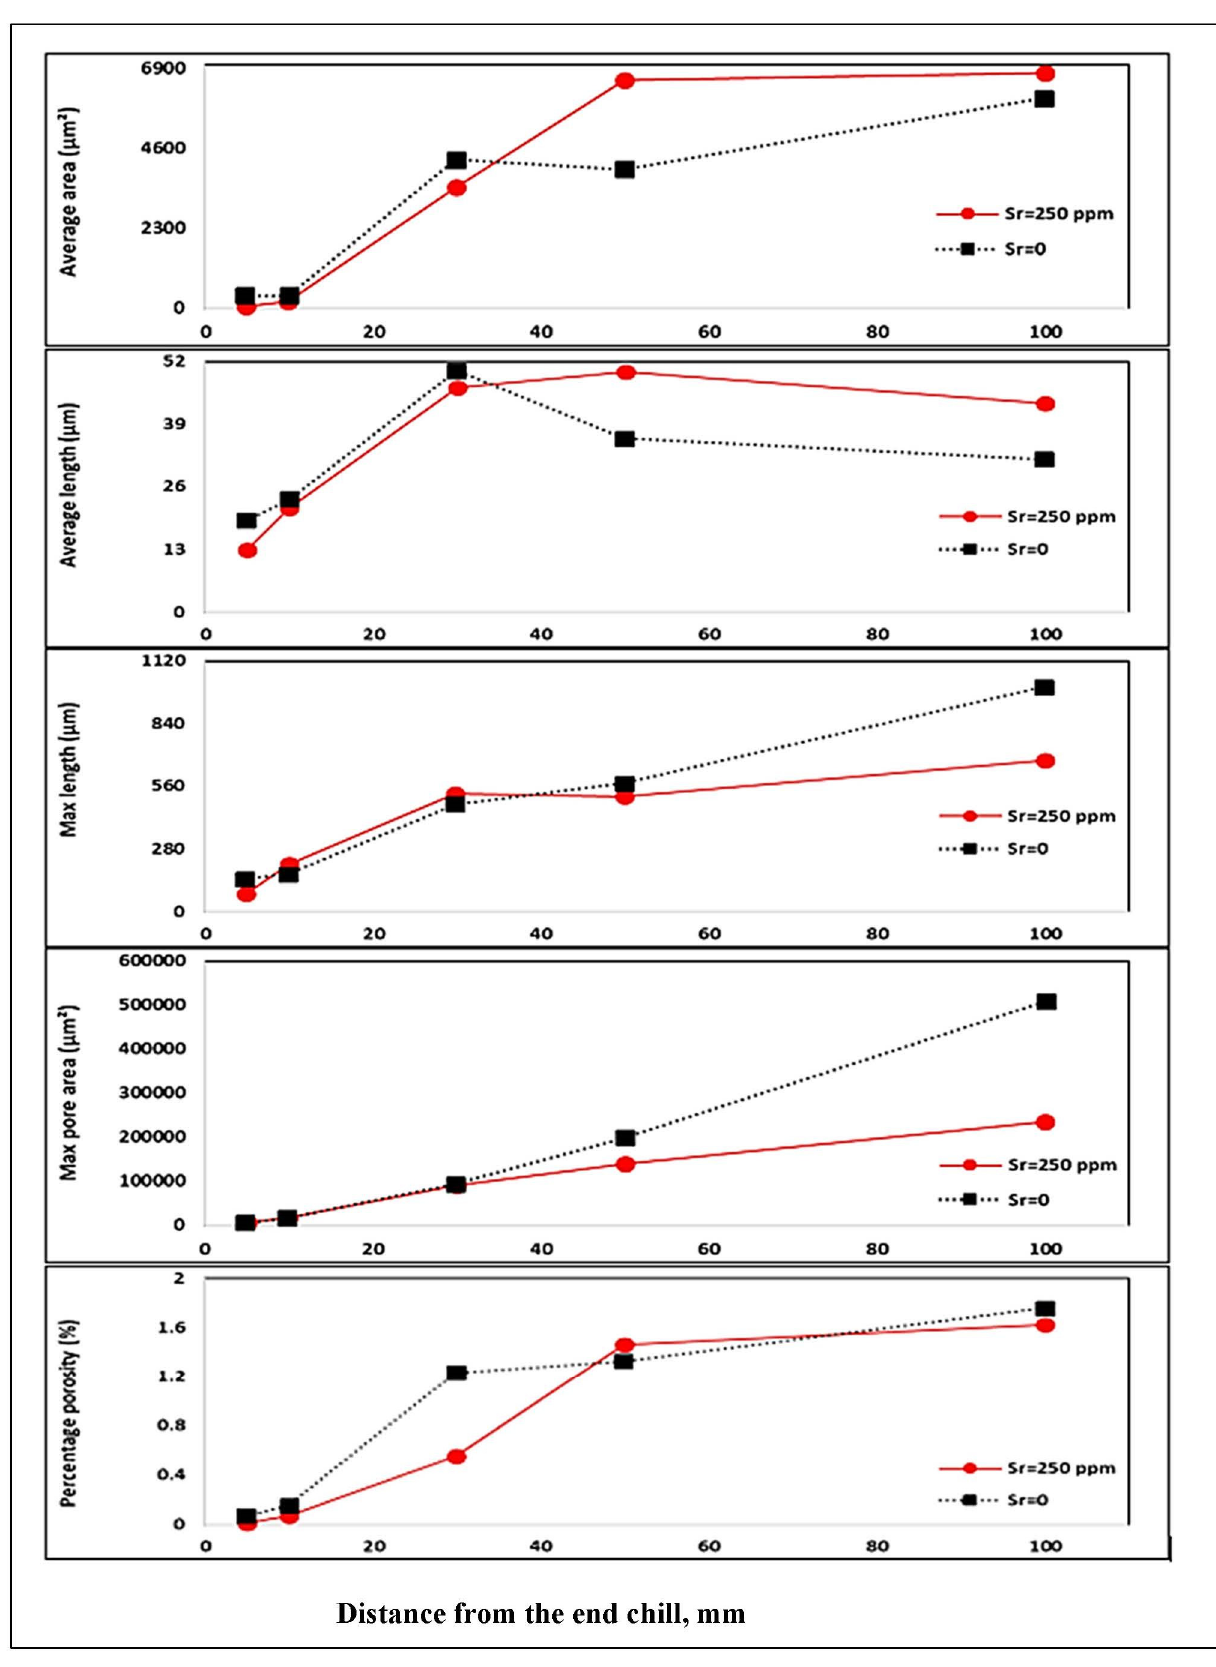
Figure 18. Porosity distribution in 319 alloy containing (H = 0.24 mL/100 g Al, Sr = 250 ppm, Ti = 0.2%) as a function of distance from the chill end.